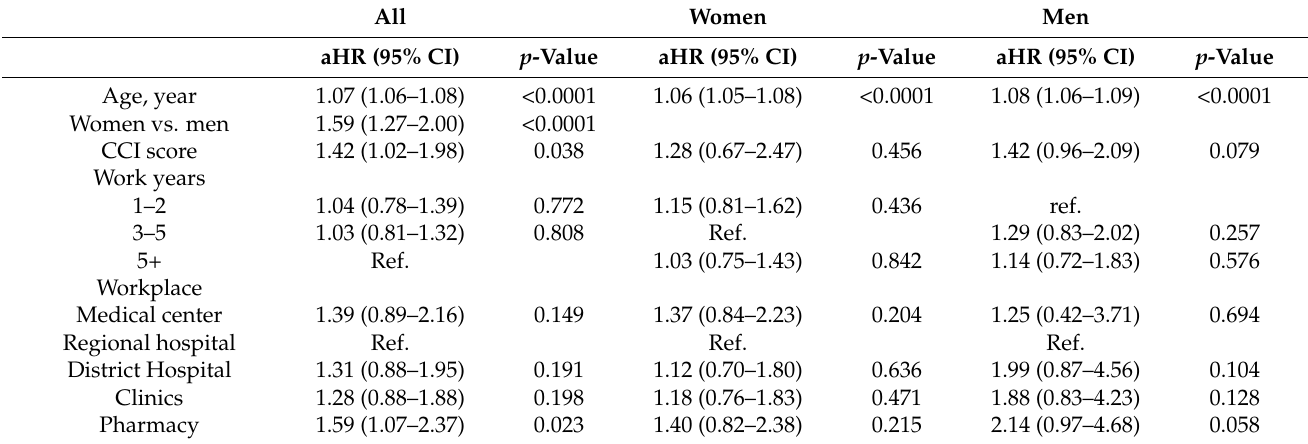
Table 4. The association between cancer incidence and pharmacist characteristics by